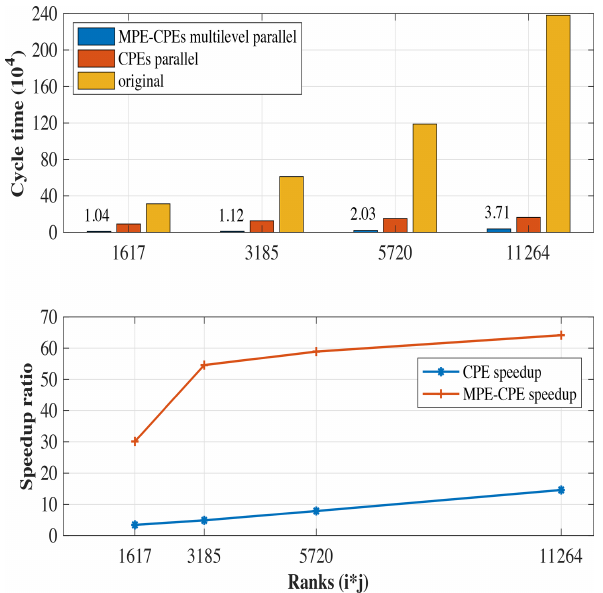
Figure 8. Performance of MPE–CPE asynchronous parallelization.